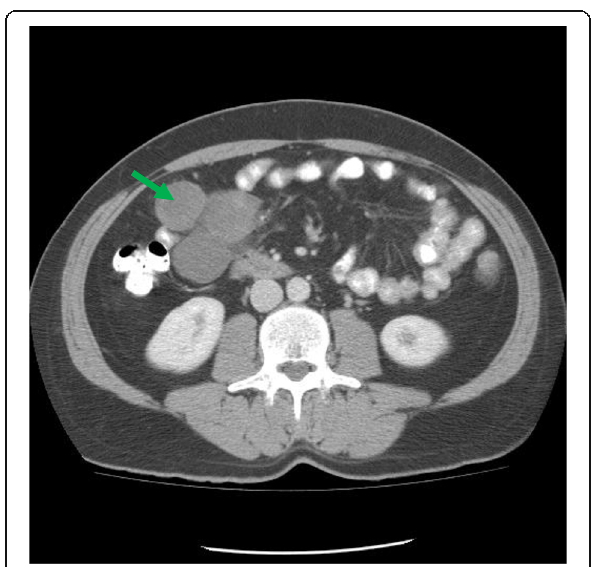
Fig. 1 Abdominal CT showed a 10 cm retroperitoneal mesentery mass (put arrows on the mass)